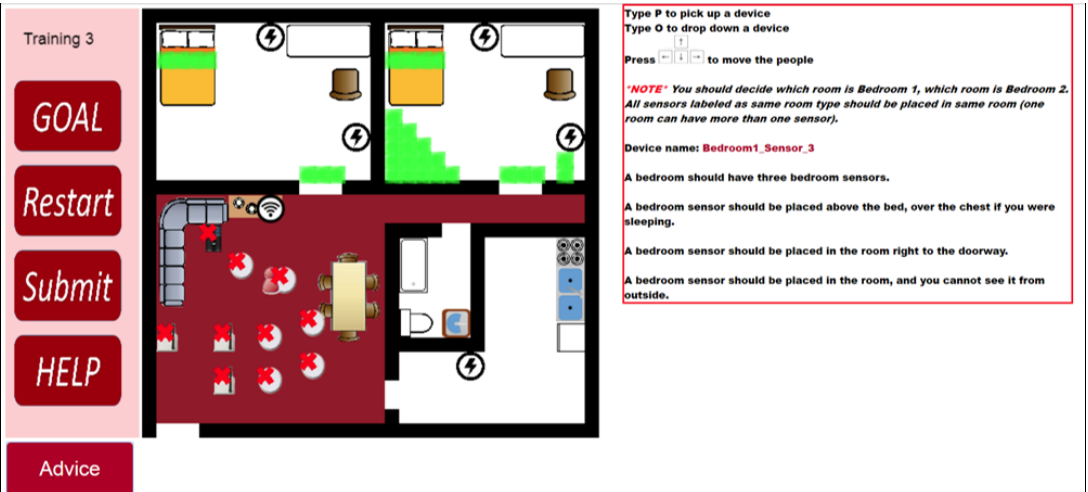
Figure 4. An example of hints for a room sensor.